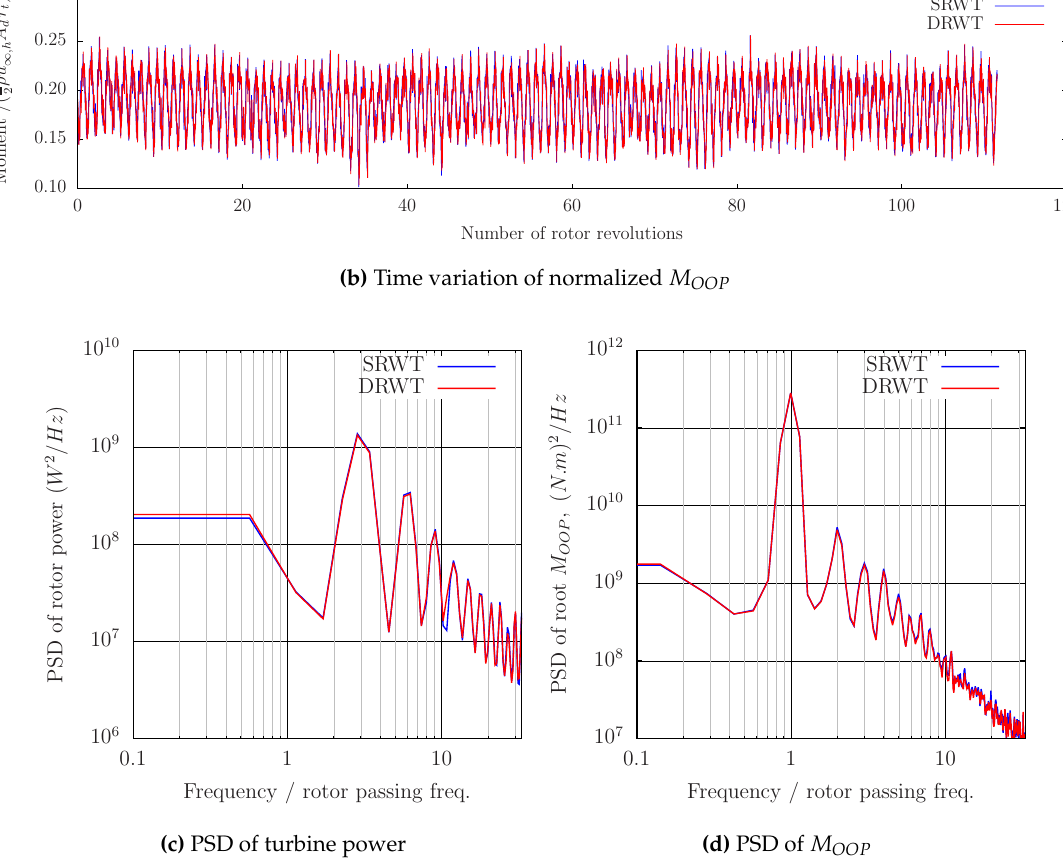
Figure 16. Stable ABL simulation results. Turbine power and out-of-plane blade root bending moment ( M OOP ) compared in the time and frequency